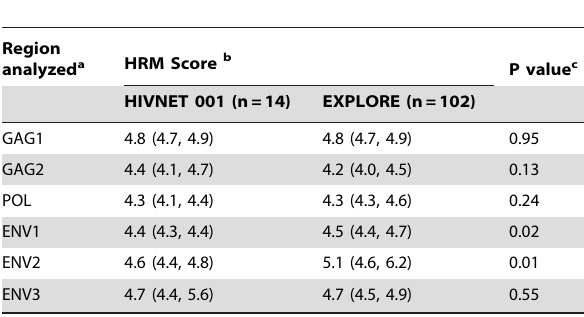
*Abbreviations: HRM: high resolution melting. CI: confidence intervals. a See Figure 1. b HRM scores were obtained for samples collected from adults with recent HIV infection. Samples from the HIVNET 001 cohort were obtained from women and from men who likely acquired HIV through intravenous drug use. Samples from the EXPLORE cohort were obtained from men who likely acquired HIV infection through sexual exposure with other men. The median number of days between collection of the sample used for testing and the individual’s last negative HIV tests was 165 days (range: 49–216) for the HIVNET 001 cohort and 189 days (range: 14–540) for the EXPLORE cohort. Median HRM scores and the first and third quartile HRM scores (in parentheses) are shown. c Wilcoxon Rank sum test.